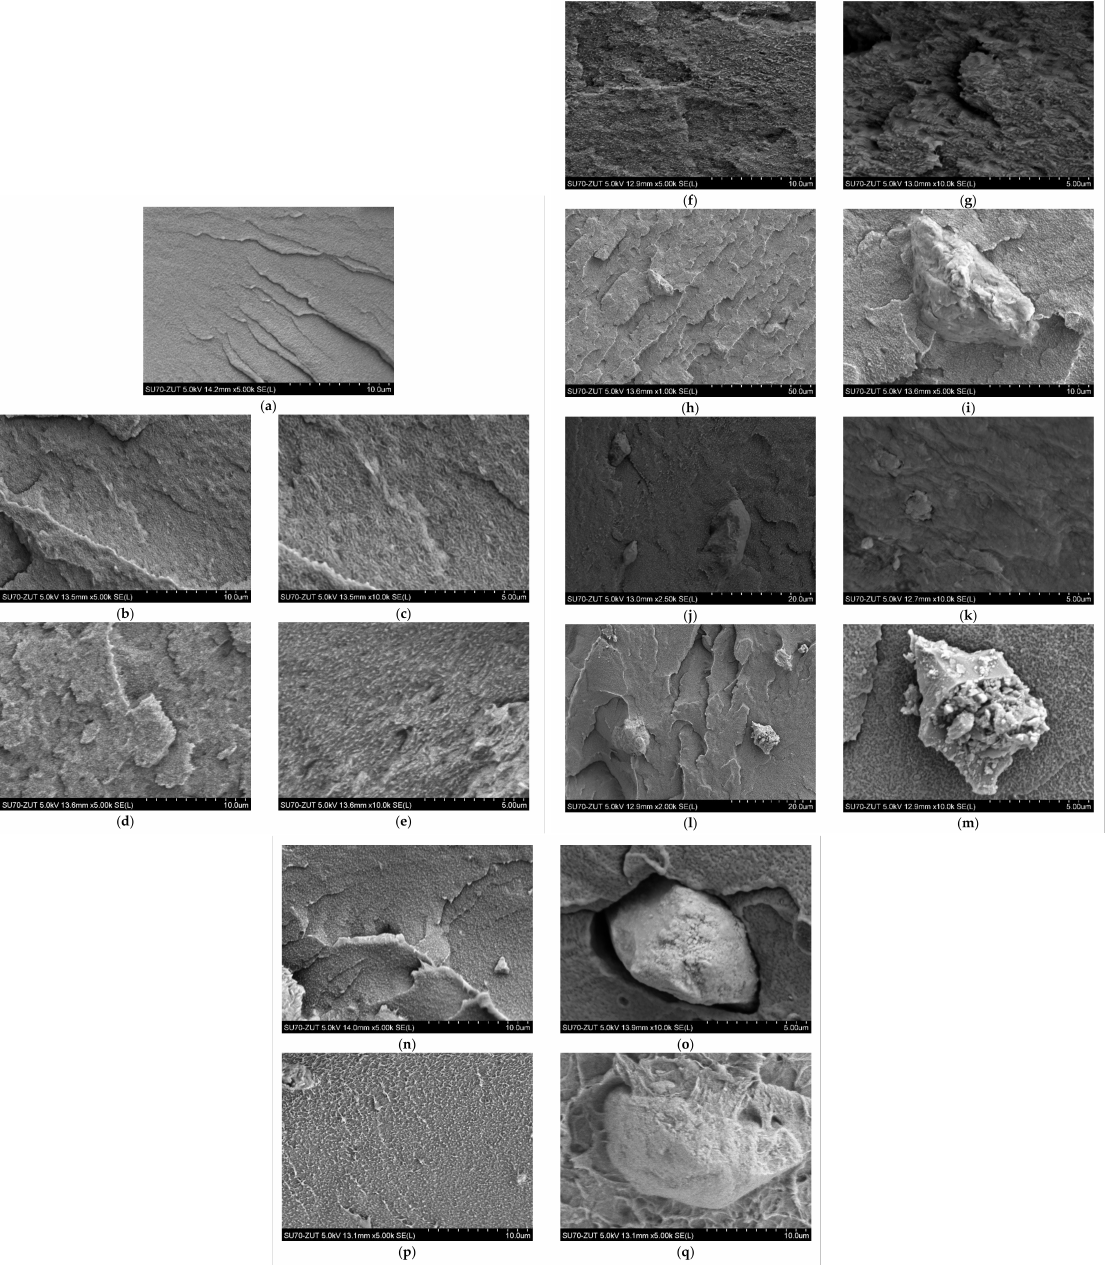
Figure 4. SEM micrographs: ( a ) PELC; ( b , c ) PELC 2.5% C20A; ( d , e ) PELC 5% C20A; ( f , g ) PELC 7% C20A; ( h , i ) PELC 5% C20A + HNT; ( j , k ) PELC 7% C20A + HNT; ( l , m ) PELC 2.5% HNT; ( n , o ) PELC 5% HNT; ( p , q ) PELC 7%